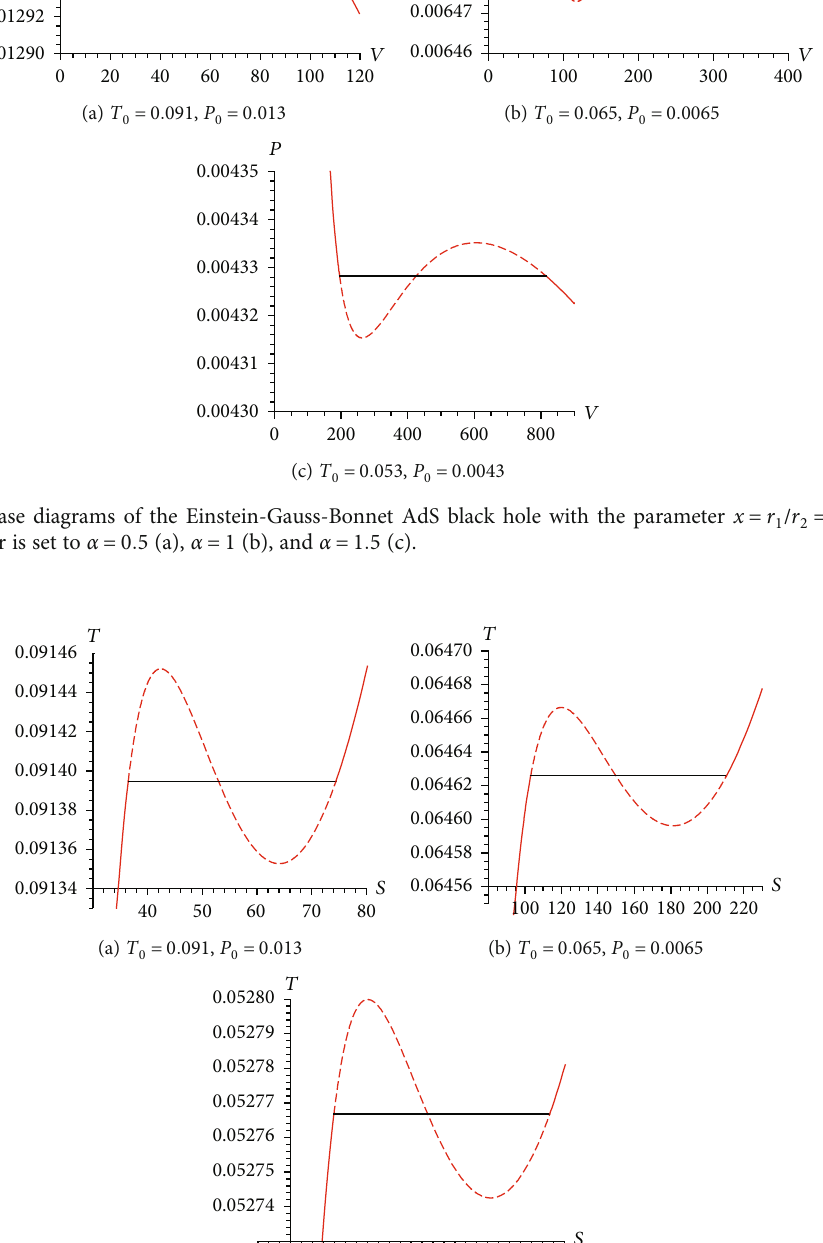
Figure 2: The T − S curves of the Einstein-Gauss-Bonnet AdS black hole phase transition with the parameter x = r are set to α = 0 : 5 (a), α = 1 (b), and α = 1 : 5